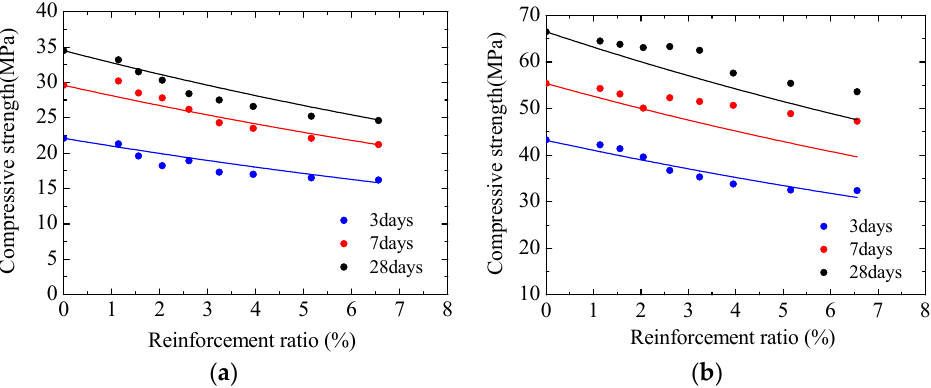
Figure 7. Comparison of predicted and test results: ( a ) C30 concrete ( b ) C60 concrete.